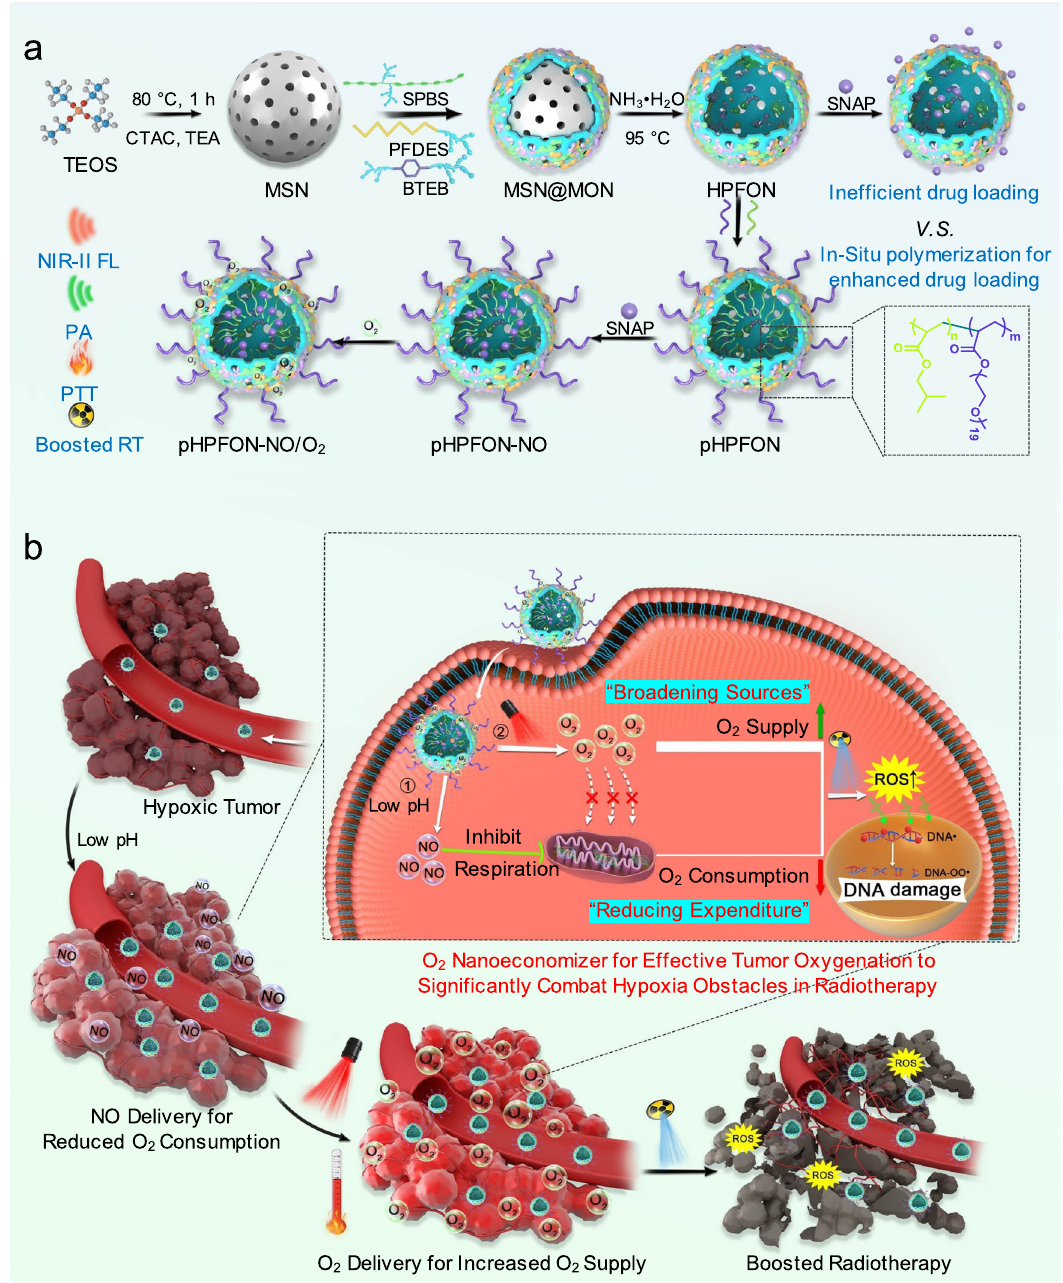
Fig. 1 Schematic illustration of fabrication and boosted radiotherapy of the smart O 2 nanoeconomizer pHPFON-NO/O 2 . a Synthetic procedures. First, sub-50 nm semiconducting polymer brush/ fl uorocarbon/phenylene triple-hybridized HPFON was prepared by deposition of bissilylated